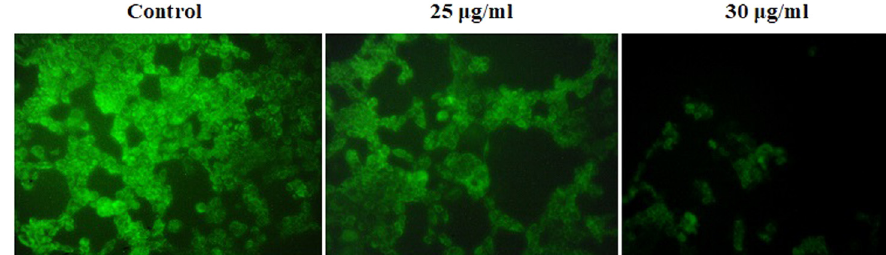
Figure 10: E ff ects of CuO NPs on MMP in HCT - 116